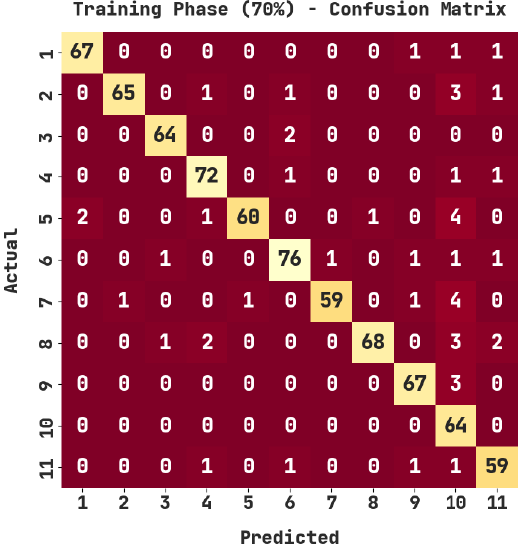
Figure 4. Confusion matrix of ASODCAE-SLR approach under 70% of TR data. Table 3 illustrate the sign language recognition outcomes of the ASODCAE-SLR methodology on 70% of TR data. The ASODCAE-SLR technique has recognized samples under class 1 with 𝑎𝑐𝑐𝑢 𝑦 , 𝑝𝑟𝑒𝑐 𝑛 , 𝑟𝑒𝑐𝑎 𝑙 , 𝐹1 𝑠𝑐𝑜𝑟𝑒 , and 𝐽𝑎𝑐𝑐𝑎𝑟𝑑 𝑖𝑛𝑑𝑒𝑥 of 99.35%, 97.10%, 95.71%, 96.40%, and 93.06%. Additionally, the ASODCAE-SLR algorithm has recognized samples under class 2 with 𝑎𝑐𝑐𝑢 𝑦 , 𝑝𝑟𝑒𝑐 𝑛 , 𝑟𝑒𝑐𝑎 𝑙 , 𝐹1 𝑠𝑐𝑜𝑟𝑒 , and 𝐽𝑎𝑐𝑐𝑎𝑟𝑑 𝑖𝑛𝑑𝑒𝑥 of 99.09%, 98.48%, 91.55%, 94.89%, and 90.28%. Similarly, the ASODCAE-SLR approach has recog- nized samples under class 3 with 𝑎𝑐𝑐𝑢 𝑦 , 𝑝𝑟𝑒𝑐 𝑛 , 𝑟𝑒𝑐𝑎 𝑙 , 𝐹1 𝑠𝑐𝑜𝑟𝑒 , and 𝐽𝑎𝑐𝑐𝑎𝑟𝑑 𝑖𝑛𝑑𝑒𝑥 of 99.48%, 96.97%, 96.97%, 96.97%, and 94.12%. At last, the ASODCAE-SLR system has rec- ognized samples under class 4 with 𝑎𝑐𝑐𝑢 𝑦 , 𝑝𝑟𝑒𝑐 𝑛 , 𝑟𝑒𝑐𝑎 𝑙 , 𝐹1 𝑠𝑐𝑜𝑟𝑒 , and 𝐽𝑎𝑐𝑐𝑎𝑟𝑑 𝑖𝑛𝑑𝑒𝑥 of 98.96%, 93.51%, 96%, 94.74%, and 90%. Table 3. Result analysis of ASODCAE-SLR approach with distinct class labels under 70% of TR data. Training Phase (70%)